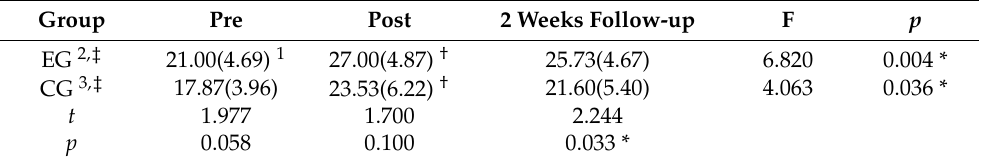
Table 3. Changes in Functional Gait Assessment (FGA) by the period. Group Pre Post 2 Weeks